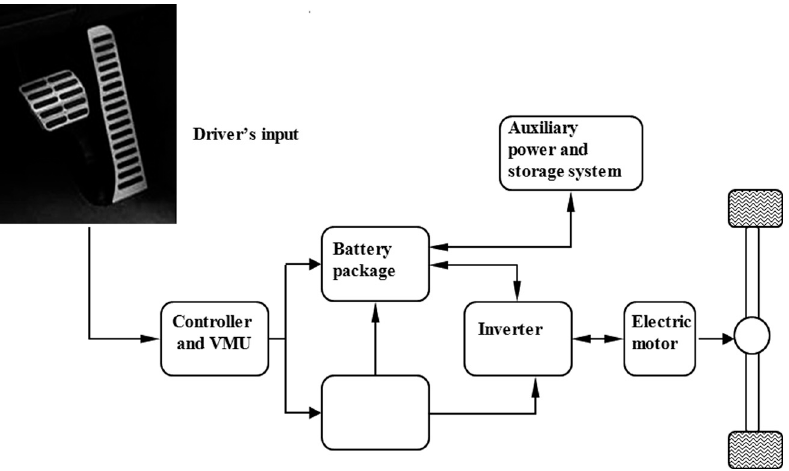
Figure 5. Controller Units in a HV.